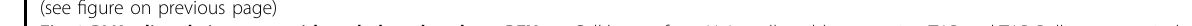
Fig. 2 PLK1 directly interacts with and phosphorylates BEX4. a Cell lysates from HeLa cells stably expressing TAP and TAP-Pellino-1 were isolated by tandem af fi nity puri fi cation (TAP). Bound proteins were immunoblotted with anti-Flag, anti-PLK1, and anti-actin antibodies. b Asynchronized HeLa cells (Asyn) were treated with nocodazole (200 ng/ml) for 16 h (Noco). The HeLa cell extracts of the three different conditions were incubated with beads bound to GST alone or to GST-fused PLK1 proteins. Bound proteins were analyzed by SDS-PAGE and immunoblotted with anti-BEX4, anti- cyclin B1, and anti-actin antibodies. c Asynchronized HeLa cells (Asyn) were treated with nocodazole (200 ng/ml) for 16 h (Noco) and transferred to fresh media for 2 h (NR 2 h). The HeLa cell extracts of the three different conditions were incubated with beads bound to GST alone or to GST-fused BEX4 proteins. Bound proteins were analyzed by SDS-PAGE and immunoblotted with anti-PLK1, anti-CDK1, anti-aurora B (Aur B), anti-cyclin B1, and anti-actin antibodies. d HeLa cell extracts were obtained from cell cultures not containing (Asyn) or containing (Noco) nocodazole (200 ng/ml). Extracts were immunoprecipitated with normal immunoglobulin IgG or anti-BEX4 antibody, then immunoblotted with anti-BEX4, anti-PLK1, anti- CDK1, and anti-actin. The asterisk represents a nonspeci fi c band. e Recombinant CDK1/Cyclin B (CDK1), PLK1, and aurora B (Aur B) proteins were mixed with kinase buffer containing [ γ 32 P] ATP. Mixtures were reacted with bead-bound histone H1 (HH1, a positive control), GST, or GST-BEX4, run in SDS-PAGE, and visualized by autoradiography. Coomassie-stained gel is shown for GST and GST-BEX4 proteins. The asterisk represents autophosphorylated CDK1 and PLK1. f Detection of phosphorylation of BEX4 by the Phos-tag reagent as described in the Materials and methods. Lysates from GFP-BEX4-expressing stable HeLa cells with or without 60 nM BI2536 (PLK1 inhibitor) in the nocodazole (200ng/ml)-treated condition for 12 h were separated by SDS-PAGE in the absence (left) or presence (right) of the Phos-tag reagent and immunoblotted with anti-GFP and anti- actin antibodies. The supershifted bands correspond to the phosphorylated BEX4 (open triangle). Unphosphorylated BEX4 is indicated by (solid